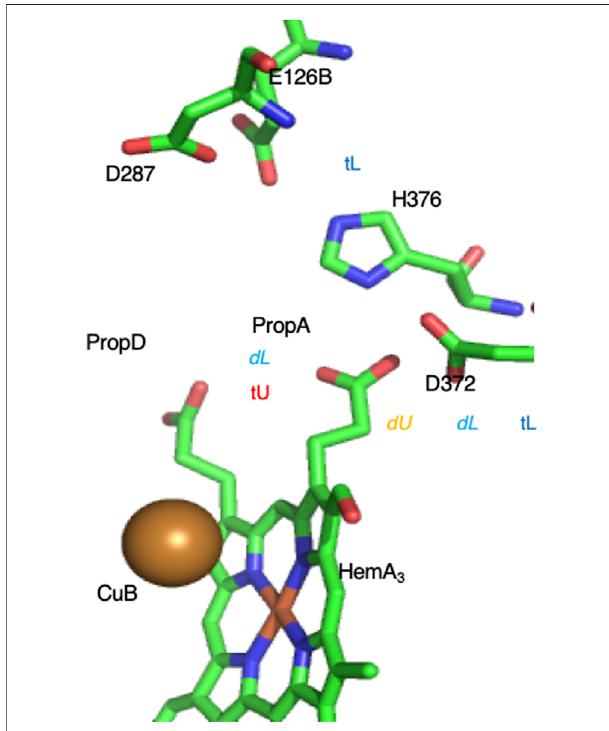
FIGURE10| ComplexPLSontheP-sideoftheB-typeCcO.Theproton movesbetweenPropA[trappedunloaded(tU),withverylowprotonaf fi nity]to D372 [dynamic unloaded (dU)] where electron transfer to Heme A 3 or CuB in theBNCactivesite15 Ådistantwillleadtoprotonloadingintothecluster (Cai et al., 2020). In the loaded state one proton is on D372. If the second proton is on PropA the system is dynamic (dL), so addition of a proton to the product water trapped in the BNC leads to the PLS unloading. If the second proton is on H386 the cluster proton af fi nity is too high to lose a proton (tL). The intra-cluster distances determine the relative energy of the loaded and unloaded tautomers. The crystal structure is likely trapped in the loaded state. Structure of Th. thermophilus CcO from PDB